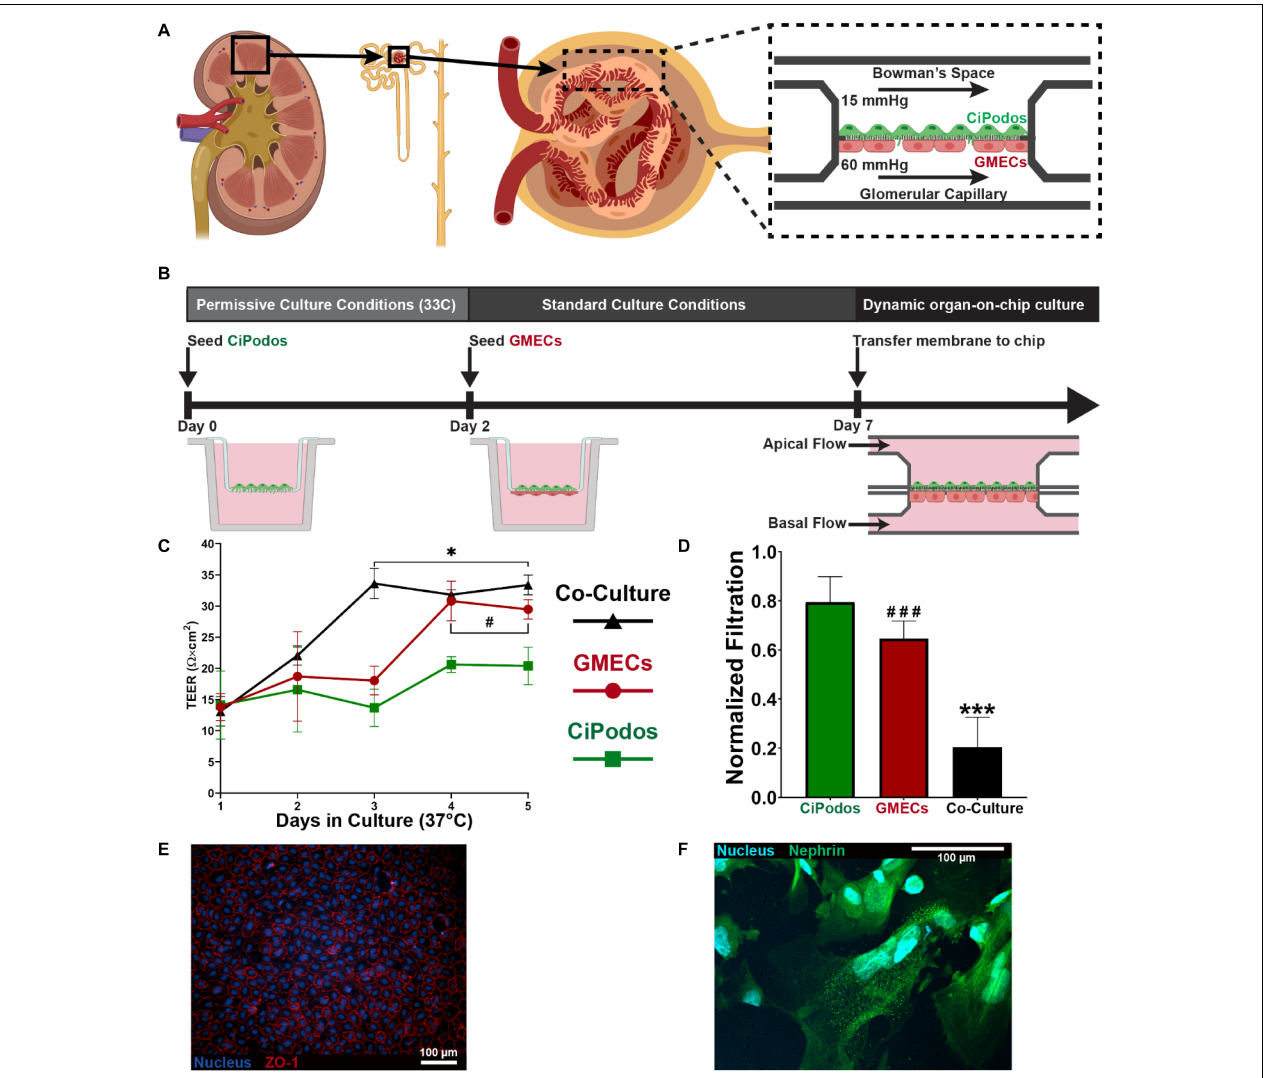
FIGURE 4 | Modeling glomerular filtration barrier; (A) Cartoon of how glomerular anatomy was modeled within the MPS (B) Schematic representation of the workflow for the development of the co-culture model of the GFB. (C) TEER measurements of podocytes only (Green), endothelial cells only (Red), and co-culture (black) during static culture on a transwell insert over the course of 5 days. Data presented as mean ± standard deviation. Statistical analysis by unpaired t-test ( N = 3; * indicates Co-Culture vs. CiPodos; # indicates GMECs vs. CiPodos). * p < 0.05, # p < 0.05. (D) Urinary filtration of albumin in 1 h on the microfluidic device. The significant decrease in the urinary filtration of albumin between the co-culture, despite similar TEER values, indicates a functional barrier as opposed to a physical barrier. Statistical analysis by one-way ANOVA with Tukey’s multiple comparisons ( N = 5; * indicates Co-Culture vs. CiPodos; # indicates GMECs vs. CiPodos). *** p < 0.0001, ### p < 0.0001. (E) Tight junctions observed in endothelial cells following culture on the MPS (F) Presence of nephrin in CiPodos after culture in the